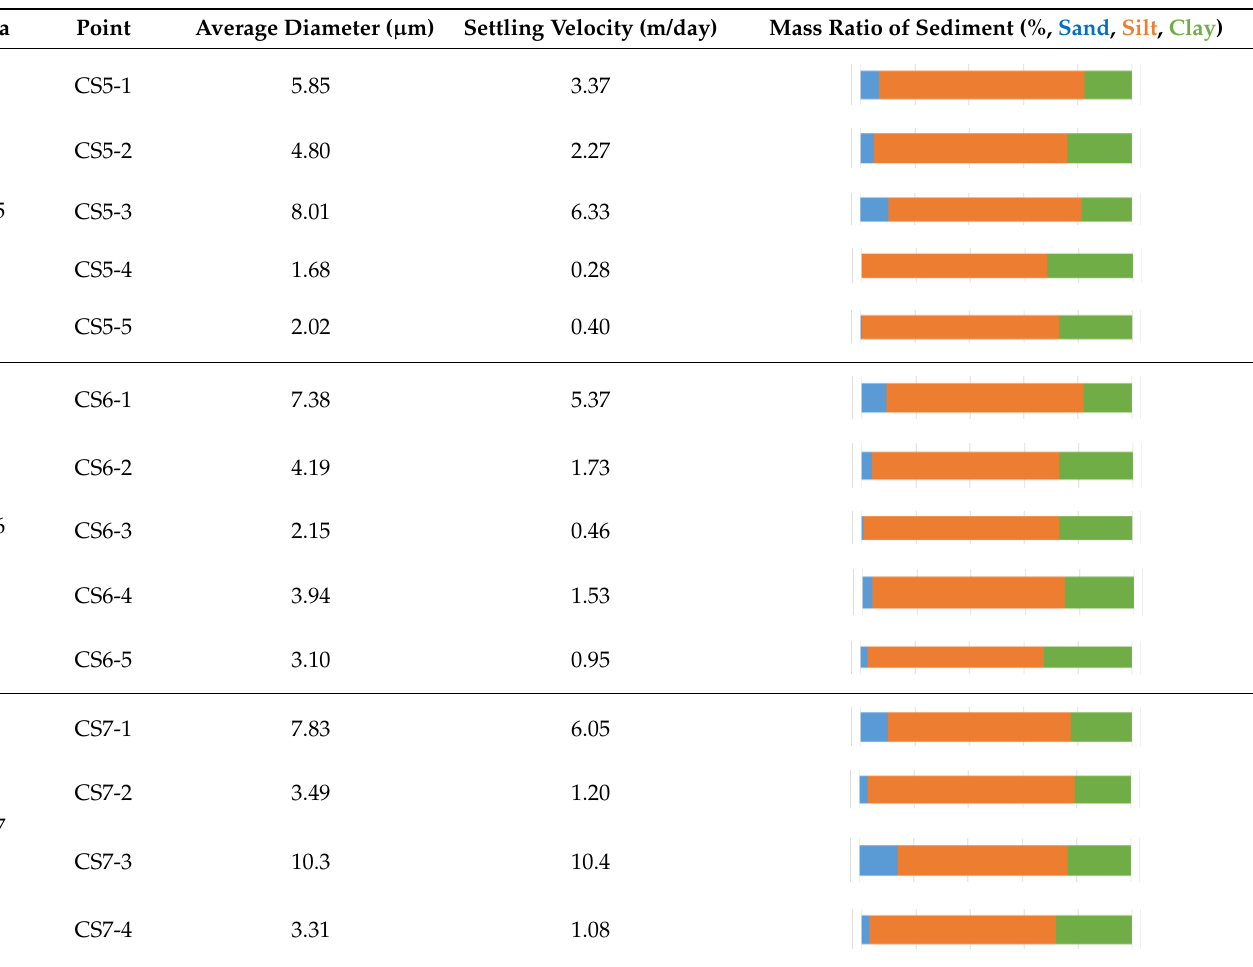
9 Table 3. Sediment characteristics across various cross sections (CS) in Tonle Sap Lake, Cambodia. Area